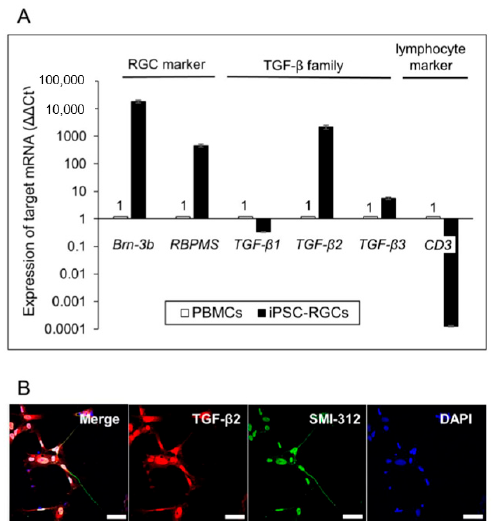
Figure 6. Detection of TGF- β in iPSC-RGCs. ( A ) Quantitative RT-PCR showed that iPSC-RGCs expressed TGF- β 2 and - β 3 mRNA, but TGF- β 1 mRNA was expressed at similar levels compared with control cells. On the other hand, iPSC-RGCs highly expressed Brn-3b and RBPMS mRNA compared with control cells. PBMCs (from the TLHD2 donor) were prepared as control cells. Results show the relative expression ( ∆∆ Ct: control cells = 1) and represent the mean ± SD ( n = 3). ( B ) ICC showed that iPSC-RGCs clearly expressed TGF- β 2 (red), as well as SMI-312 (green), on their surface. No staining was seen with the isotype control (mouse, goat, and rabbit IgG). Cell nuclei were counterstained with DAPI. Scale bars, 50 µ m. Int. J. Mol. Sci. 2020 , 21 , x FOR PEER REVIEW